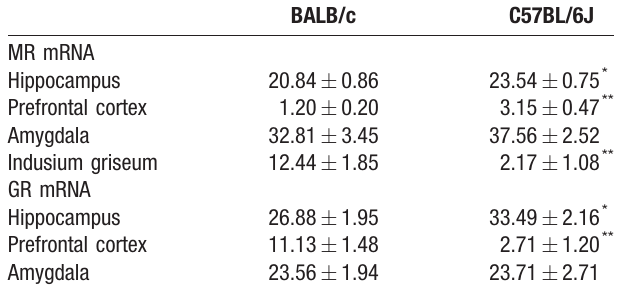
Table 1. MR and GR mRNA expression as gray value of optical densities (mean (cid:3) SEM) in hippocampus, prefrontal cortex, amyg- dala, and induseum griseum of BALB/c and C57BL/6J mice.